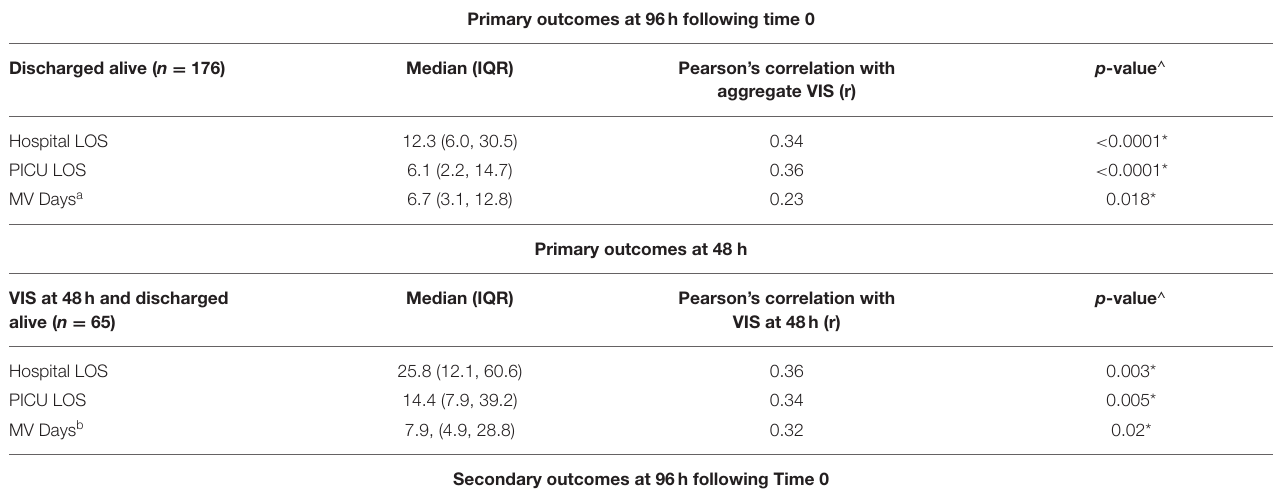
TABLE 2 | Aggregate vasoactive-inotropic score (VIS) at 96h of hemodynamic drug support and its correlation with primary and secondary outcomes. Primary outcomes at 96h following time